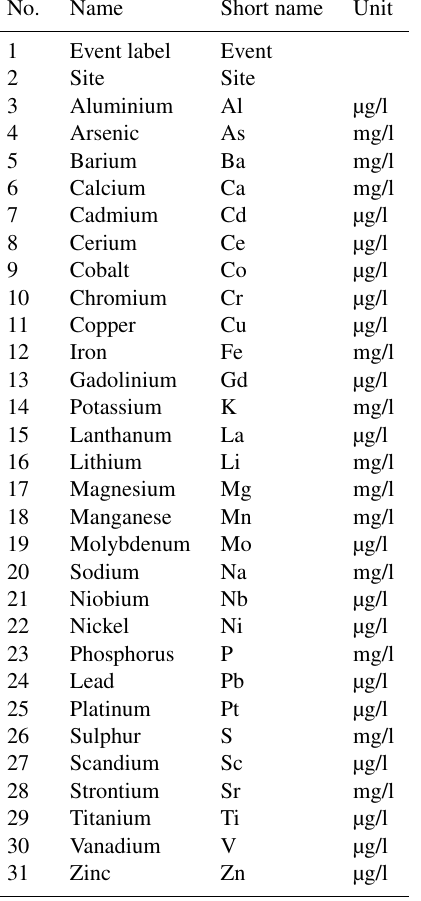
Table 7. Structure of the pore water ion characterisation via ICP- OES data set at PANGEA (Lasser and Karius, 2020). The data give sample locations and the concentrations of various ions dissolved in the water samples.